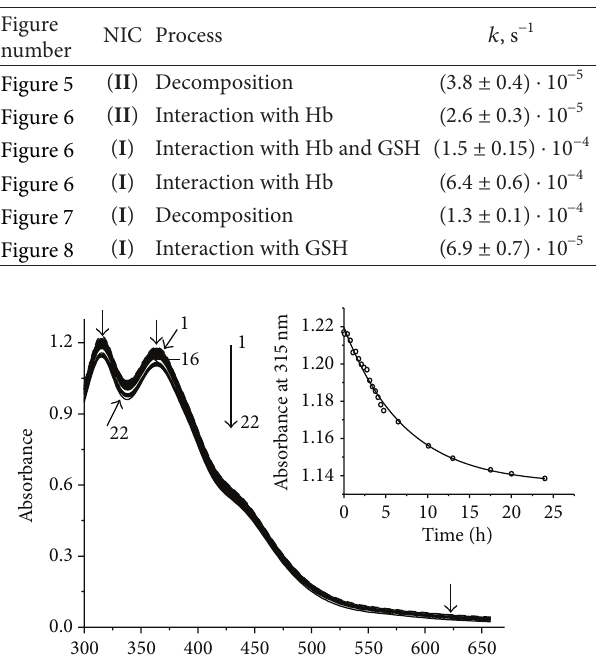
Table 2: Results of kinetic experiments (average of three).